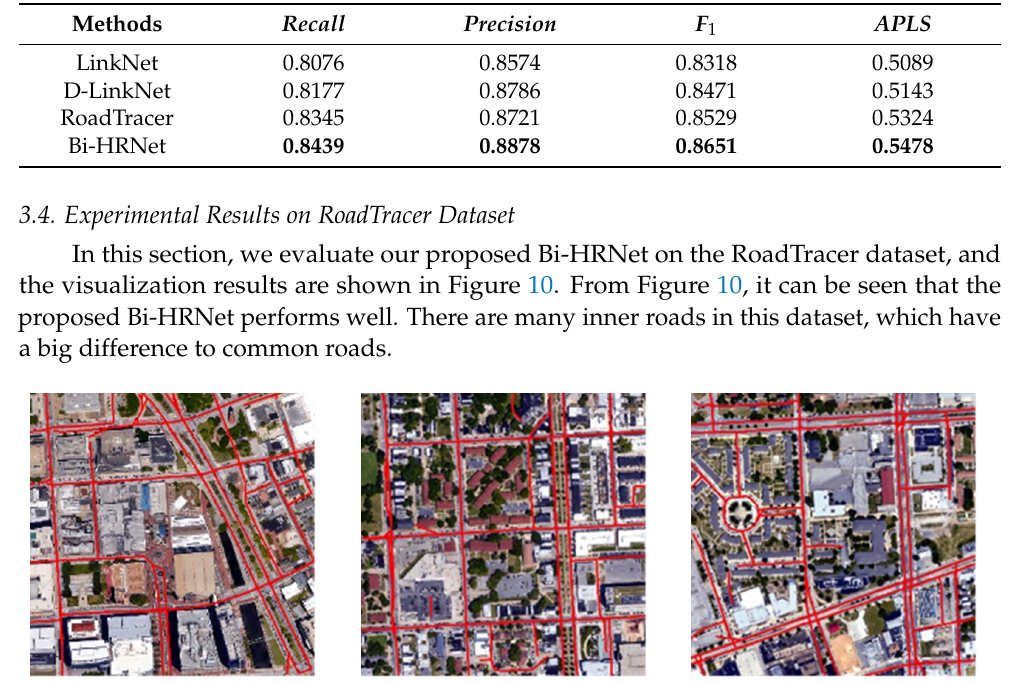
Table 2. Comparison of LinkNet, D-LinkNet, RoadTracer, and the proposed Bi-HRNet on the RoadTracer